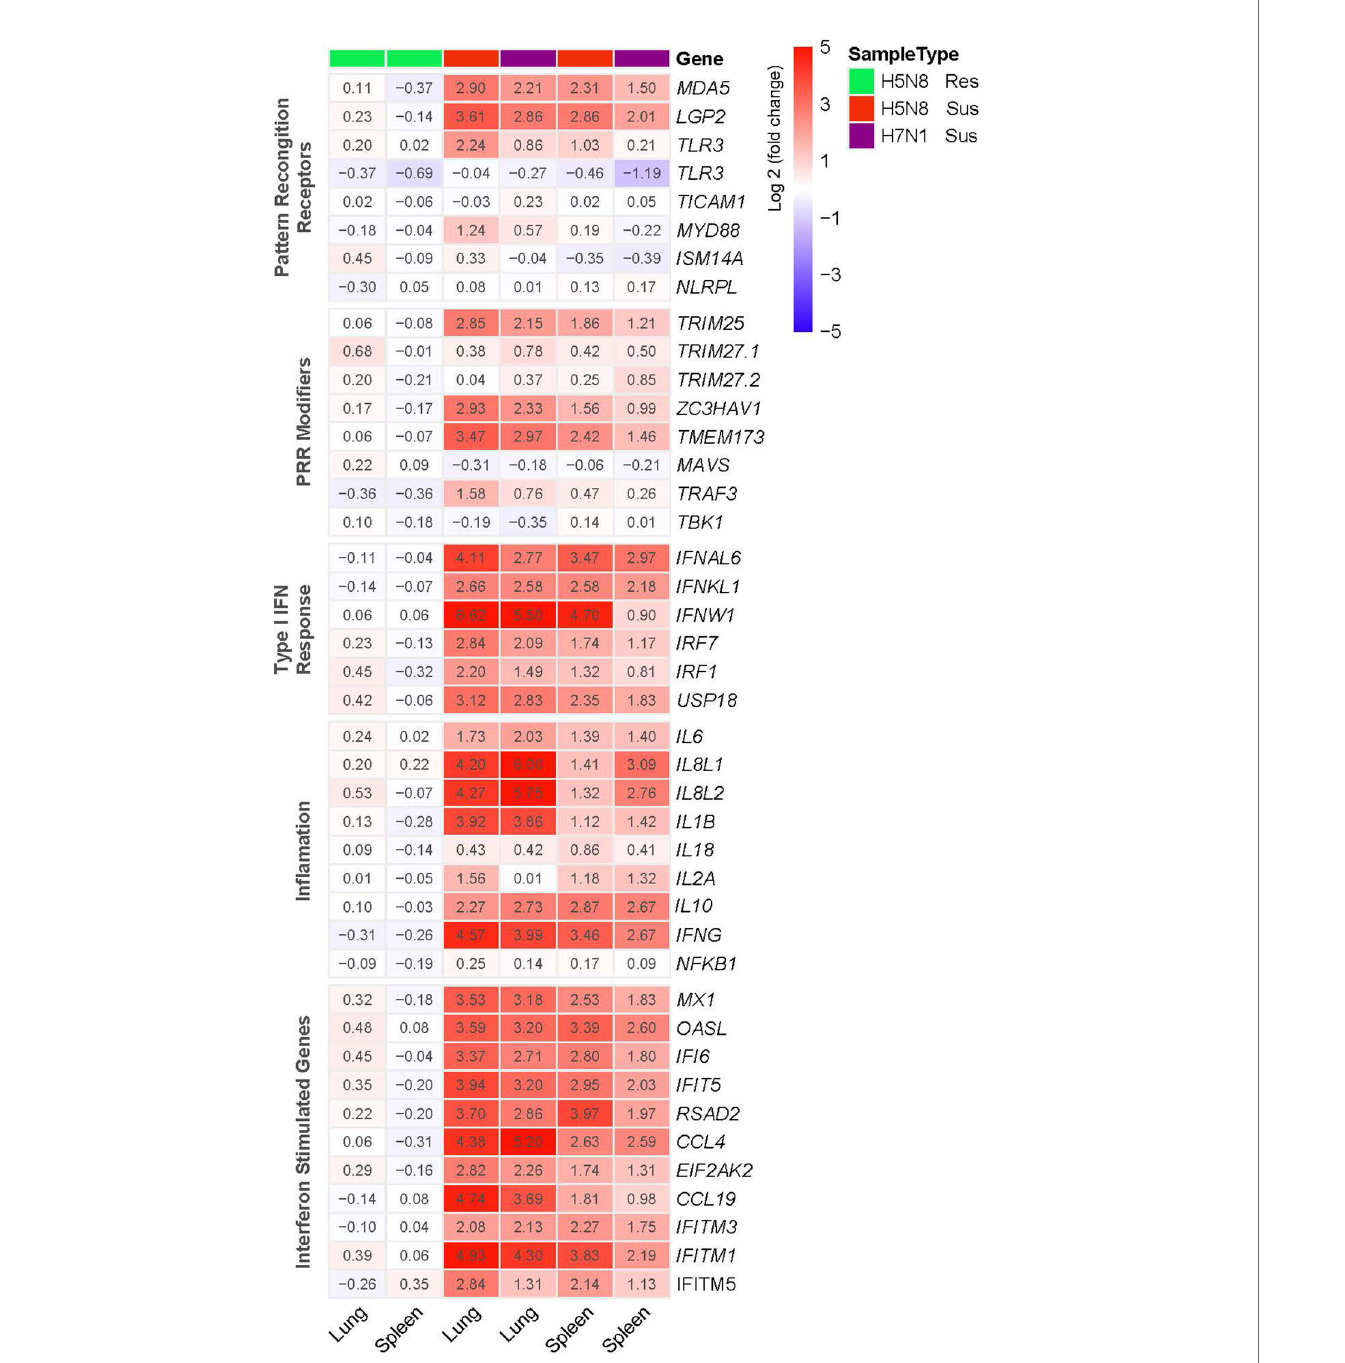
FIGURE 3 | Heatmap illustrating the log2(fold change) in expression of genes representative of innate immune responses in lungs and spleens collected at 3 dpi from susceptible (Sus) and resistant (Res) H5N8 or H7N1 inoculated chickens. Columns were clustered using pheatmap (RRID : SCR_016418) in ( Supplementary Figure 5 ). To further elucidate if the minor transcriptomic changes in resistant chickens were associated with lower viral replication and shedding by the oral route, we compared virus titers in 3 dpi oral swabs from resistant vs susceptible H5N8 inoculated chickens obtained in our previous experiment (20).